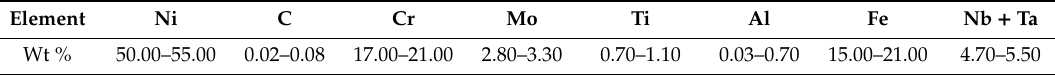
Figure 1. ( a ) Image of the computer-aided design (CAD) model of the entire electron beam melting (EBM) build, and ( b ) illustration of the coated specimen. The arrow indicates the build direction (BD). Table 2. Nominal chemical composition of Alloy 718 powder used for coating.